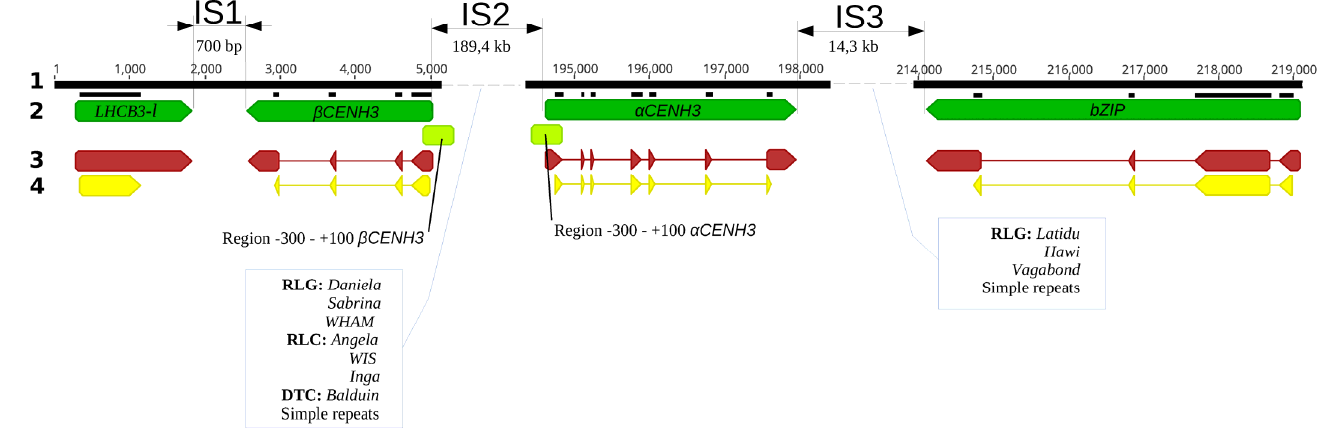
Figure 1. The structure of the CENH3 locus in rye ( S . cereale ). 1: size in kb; 2: syntenic genes appear as dark-green fingerpost arrows; 3: exon–intron structure of genes at mRNA level, where exons appear as fingerpost arrows; 4: coding regions of genes appear as yellow fingerpost arrows. Light-green rectangles depict − 300 and +100 regions around the TSSs of α CENH3 and β CENH3 , where functional motifs were searched for.